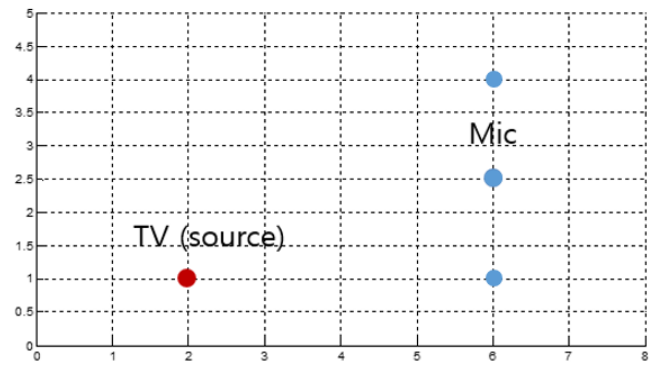
Figure 6. Placement of TV and microphone. Table 3. Datasets used for the experiments. * A total of 10% of each set of training data was used for the development data with no-overlap with the training data.